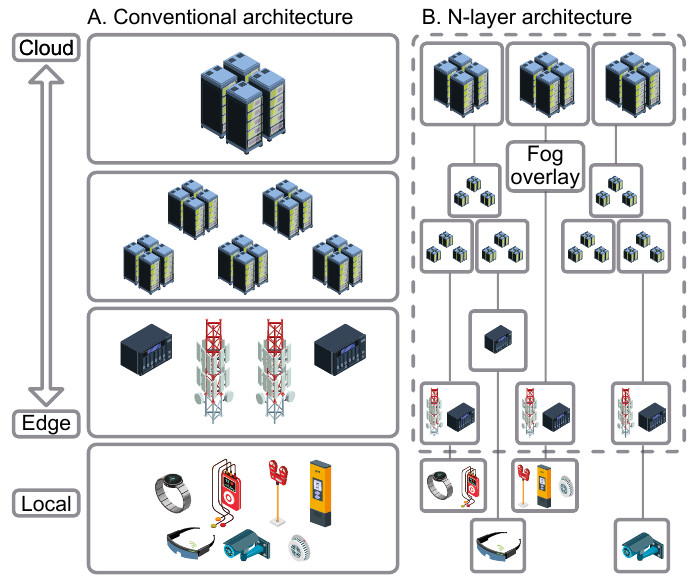
Figure 2. Most commonly analyzed computing